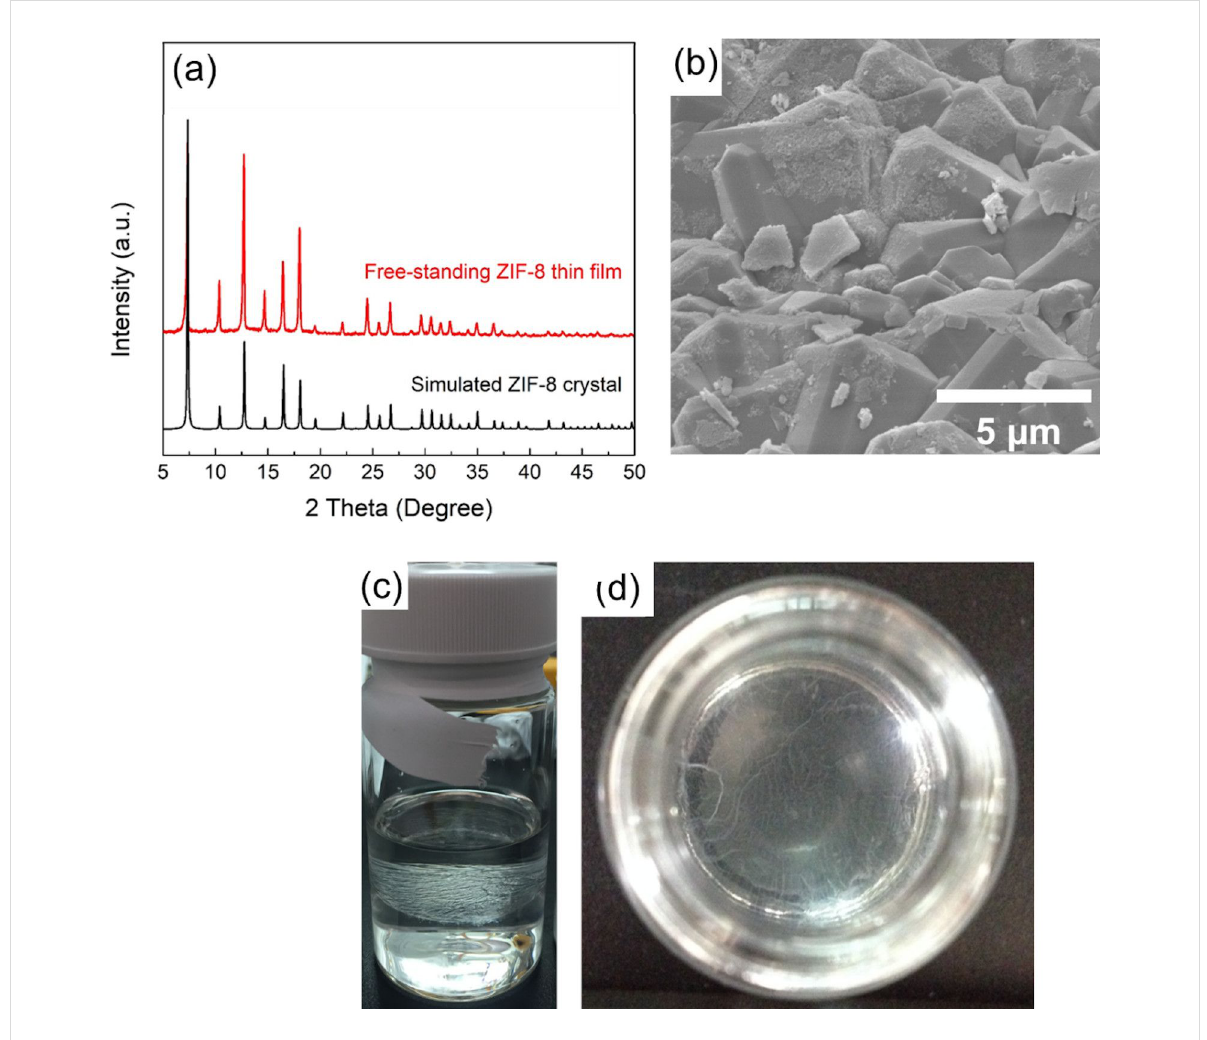
Figure 1: (a) XRD patterns, (b) FE-SEM image, (c) side view, and (d) top view of the free-standing ZIF-8 thin